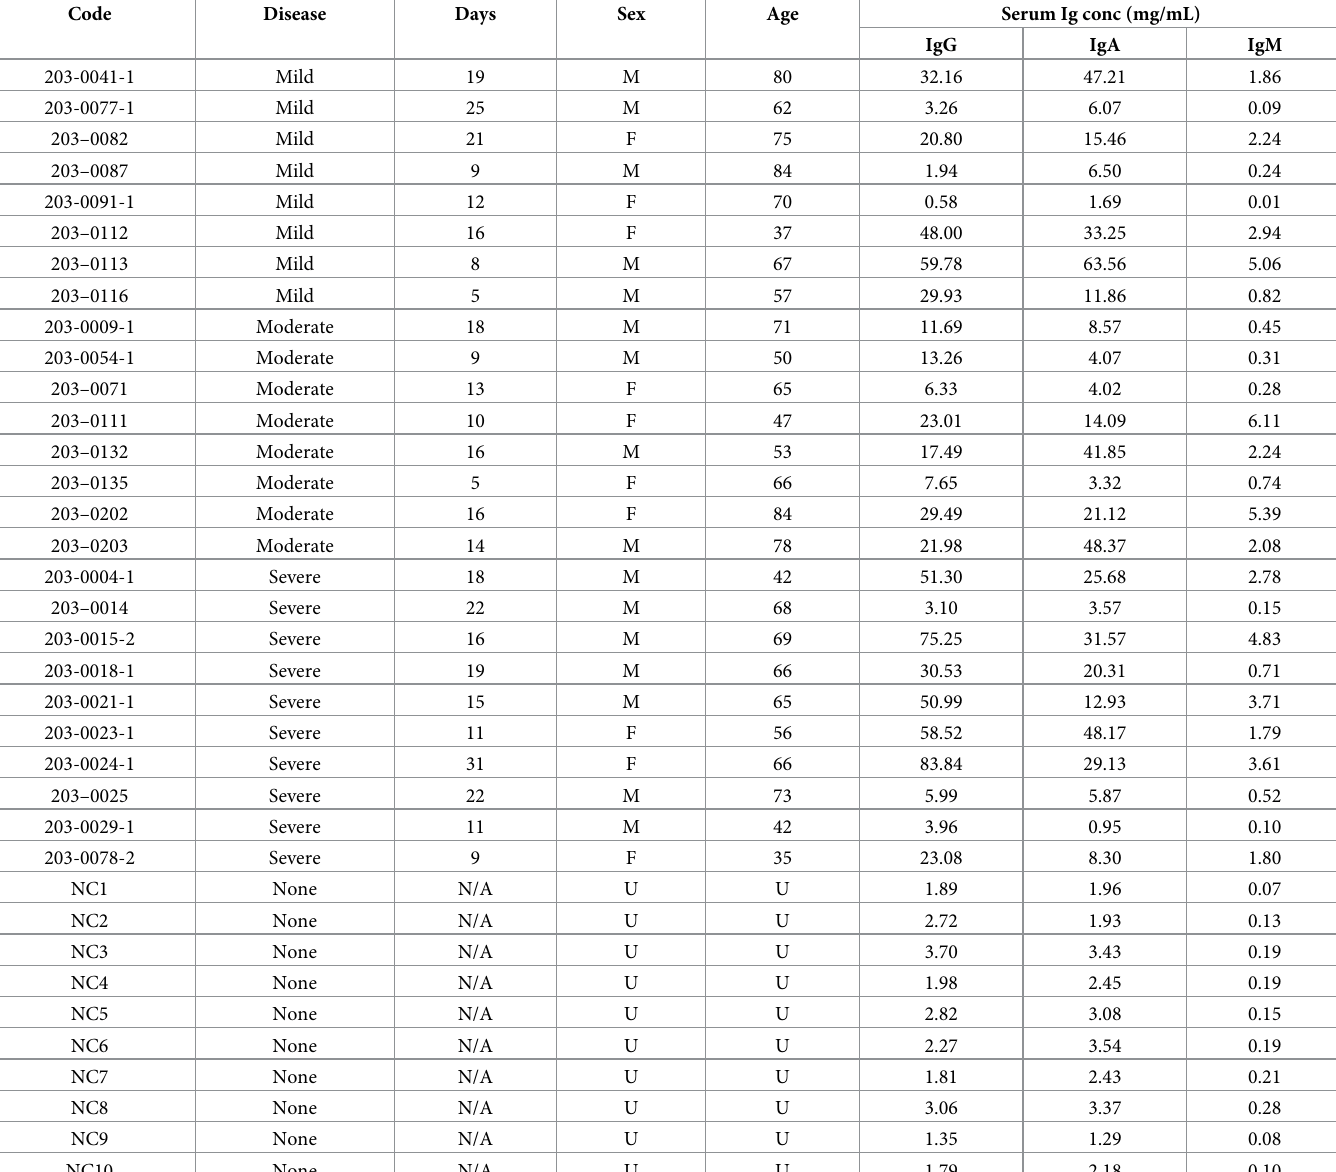
Table 2. Serum sample information including biobank code, COVID-19 disease status of individual at sampling time (mild, moderate, severe, or non-COVID-19 (NC)), days post-symptoms onset at sampling time (N/A–not applicable), biological sex (M, male; F, female; U, not recorded), patient age at time of sampling (U, not recorded), and serum IgG, IgA, and IgM